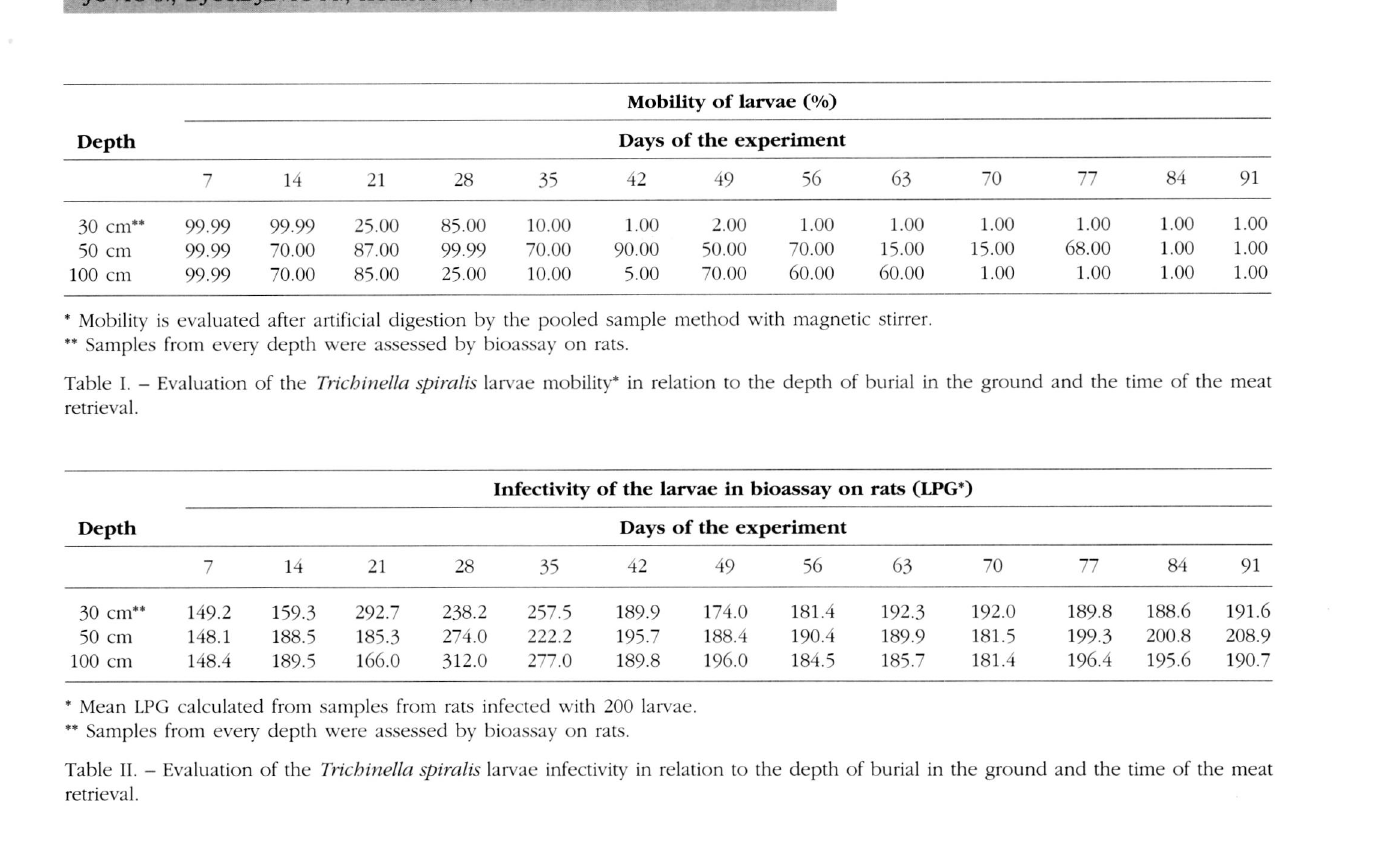
Table II. - Evaluation of the Trichinella spiralis larvae infectivity in relation to the depth of burial in the ground and the time of the meat retrieval.